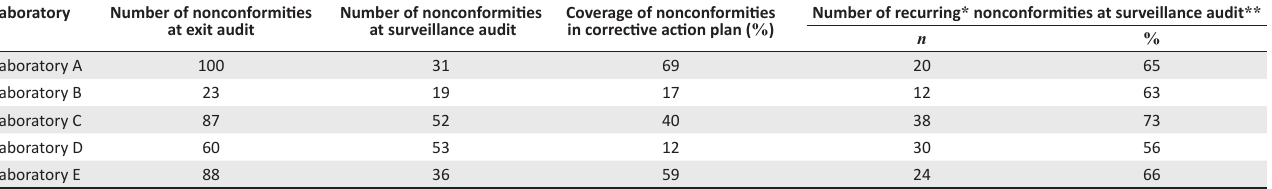
FIGURE 3: Performance of laboratories A, C, D and E in the 12 Quality System Essentials TABLE 1: Number of nonconformities at exit and surveillance audits and implementation of the corrective action plan by the laboratory. Laboratory Number of nonconformities at exit audit